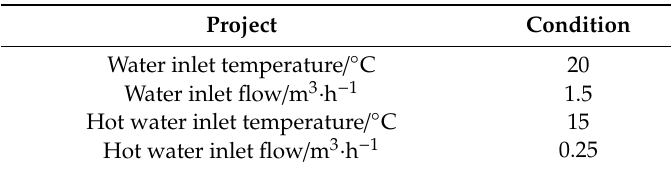
Table 1. Experimental test condition.